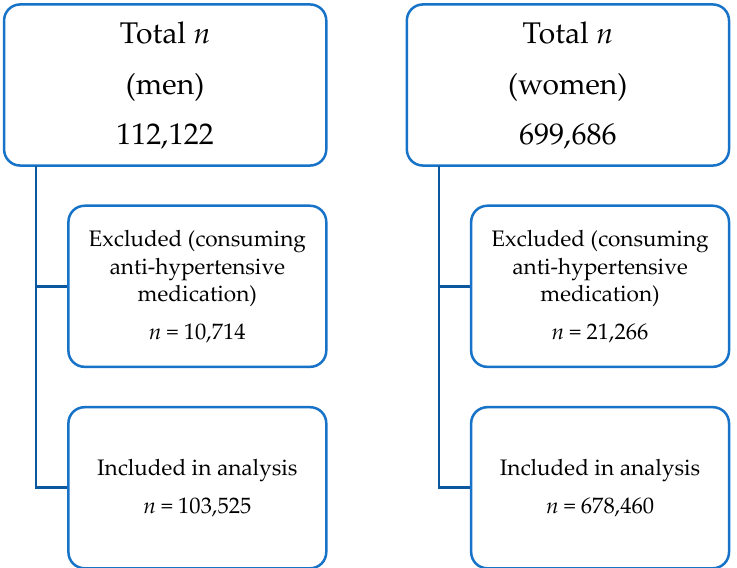
Figure 1. Sample flow of the study population.